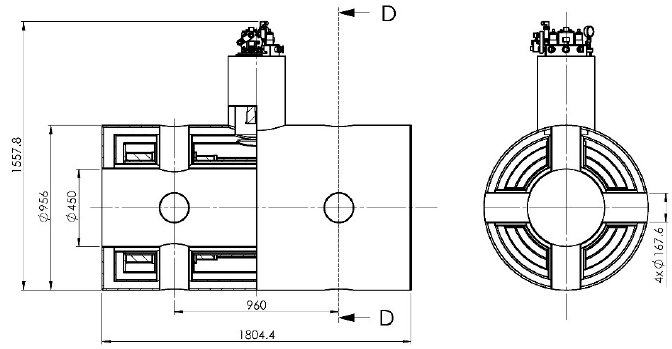
Figure 5. Sketch of superconducting magnet dimensions without external magnetic shielding.